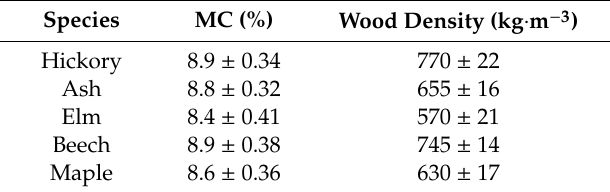
Table 1. Moisture content (MC) and wood density of analyzed wood species; ±